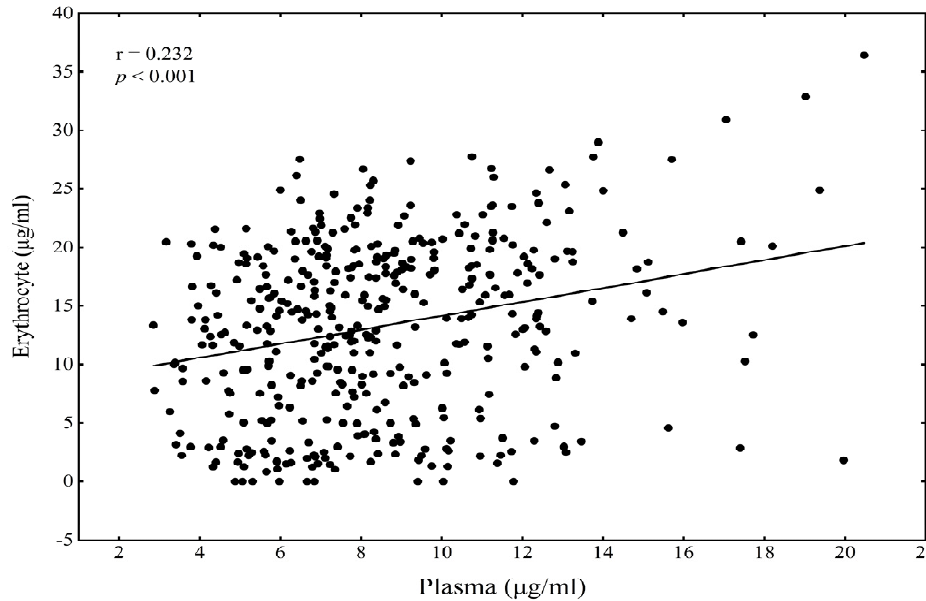
Figure 2. The correlation of plasma DHA with erythrocyte DHA among children. Table 2. The correlation of food items with plasma and erythrocyte DHA status among